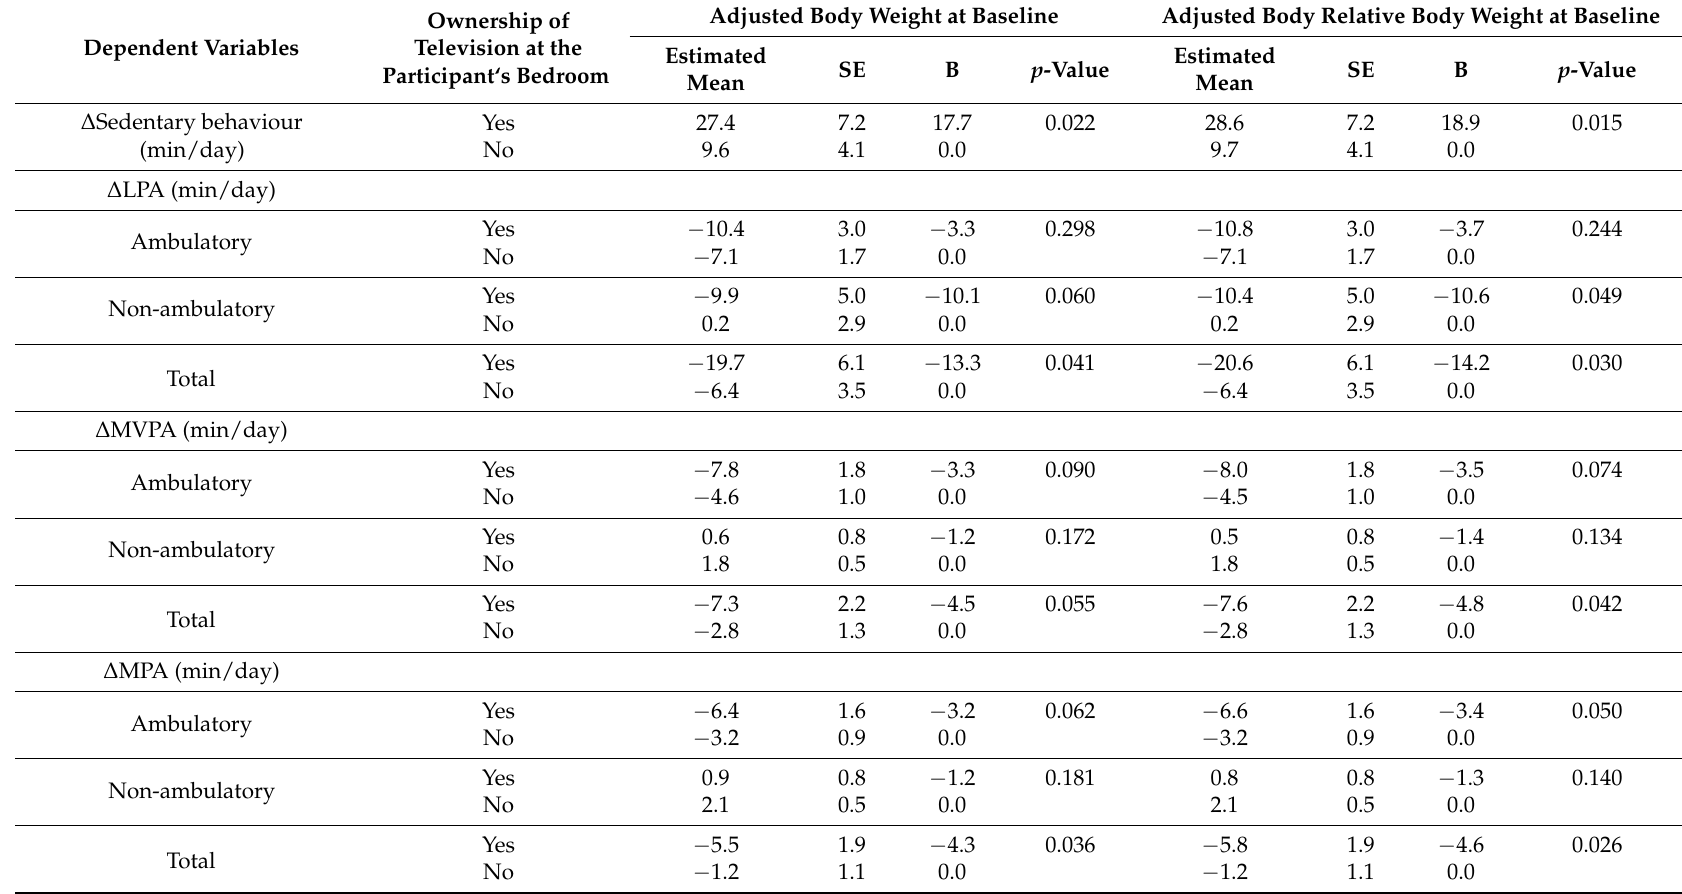
Table 5. Associations between change of sedentary behaviour or physical activity and bedroom television ownership. Adjusted Body Weight at Baseline Adjusted Body Relative Body Weight at Baseline Ownership of Dependent Variables Television at the Estimated